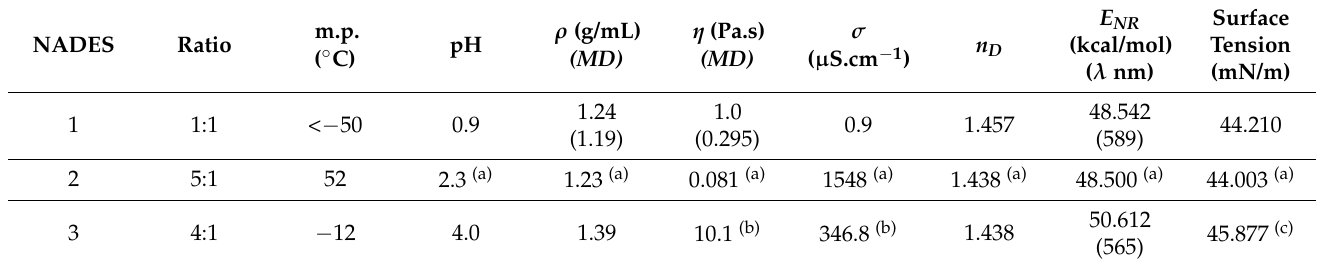
Table 4. Physicochemical properties of the NADES: molar ratio, melting point (m.p.), pH, density ( ρ ), viscosity ( η ), conductivity ( σ ), refraction index (nD), and polarity ( E NR ). Experimental and computational measurements were performed at 25 ◦ C.